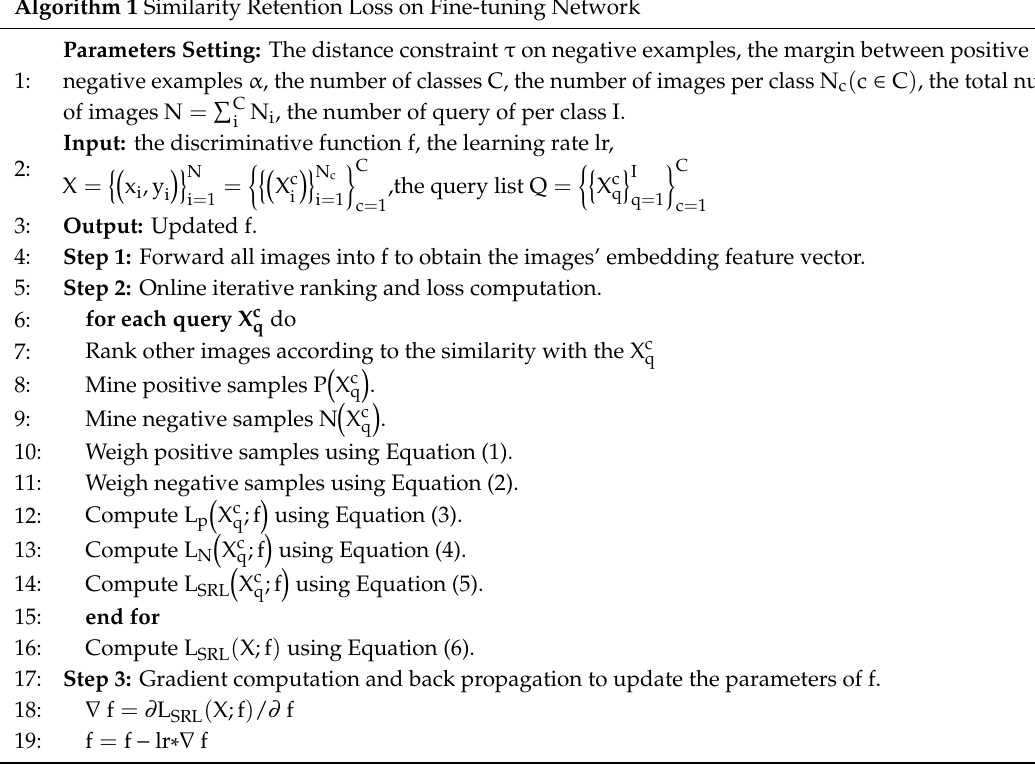
Algorithm 1 Similarity Retention Loss on Fine-tuning